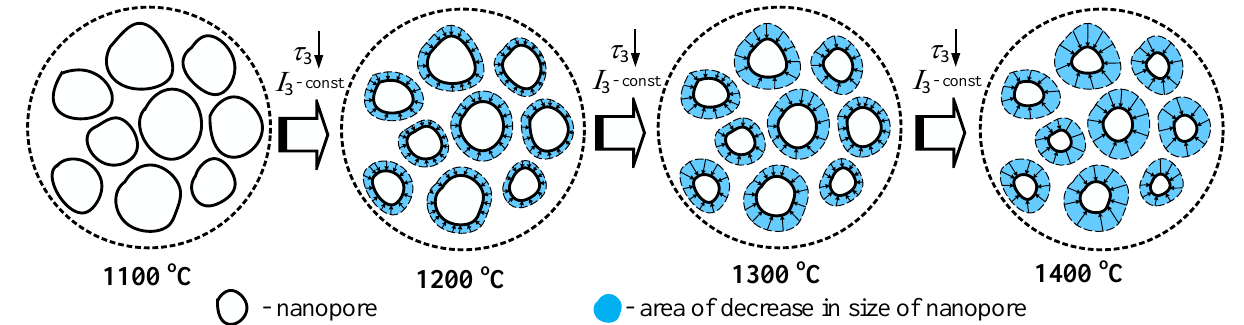
Figure 4. Diagram explaining the evolution of nanopores near grain boundaries in MgAl 2 O 4 ceramics sintered at 1100 – 1400 °C during 2 h.